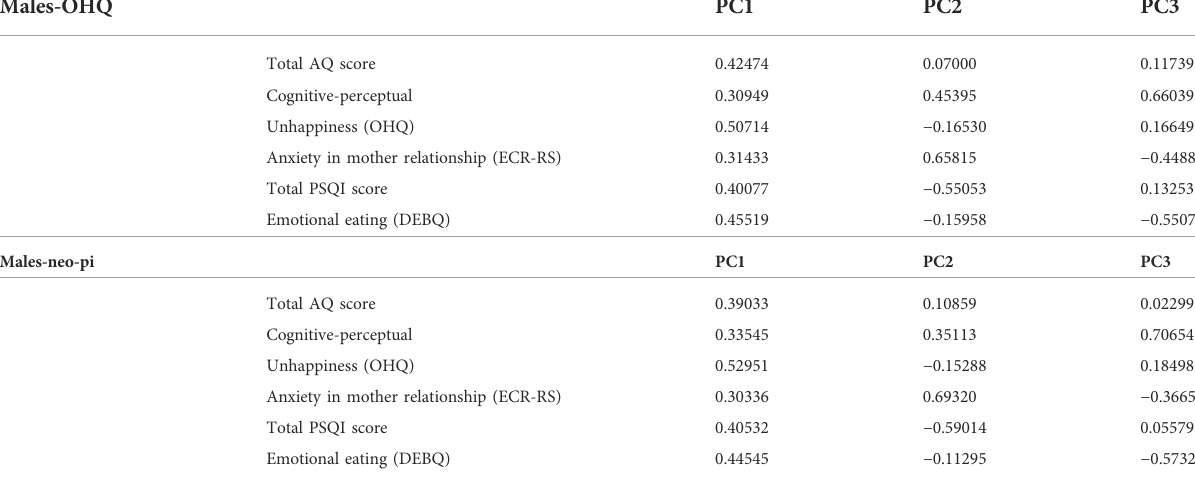
TABLE 6 Loadings for each variable across the three largest principal components in the subdivided analyses limited to males ( N = 106).